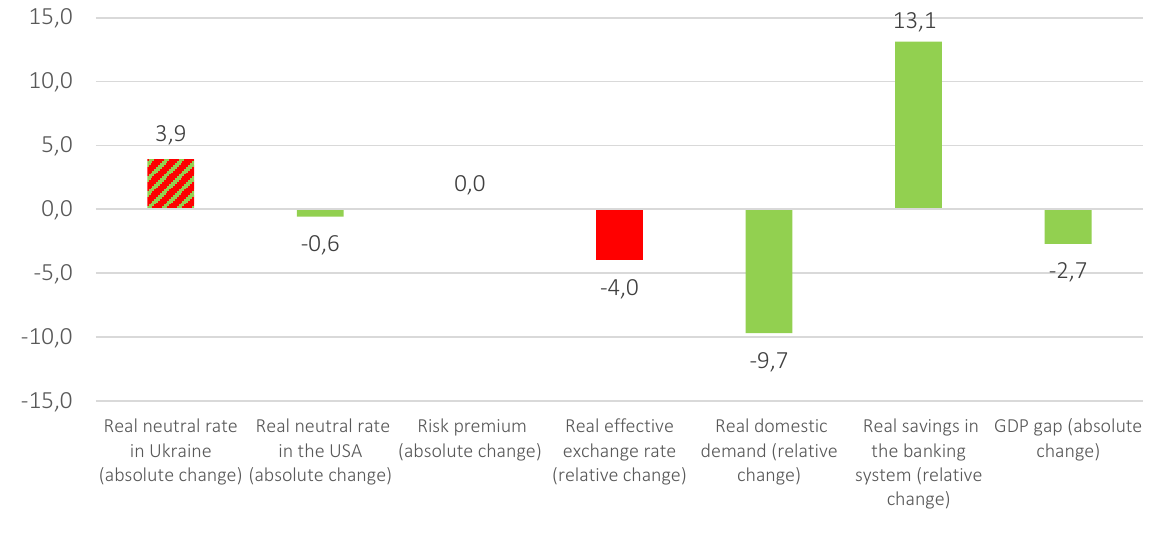
Figure 2. Change in the neutral interest rate and its factors in Ukraine (first quarter of 2021 compared to